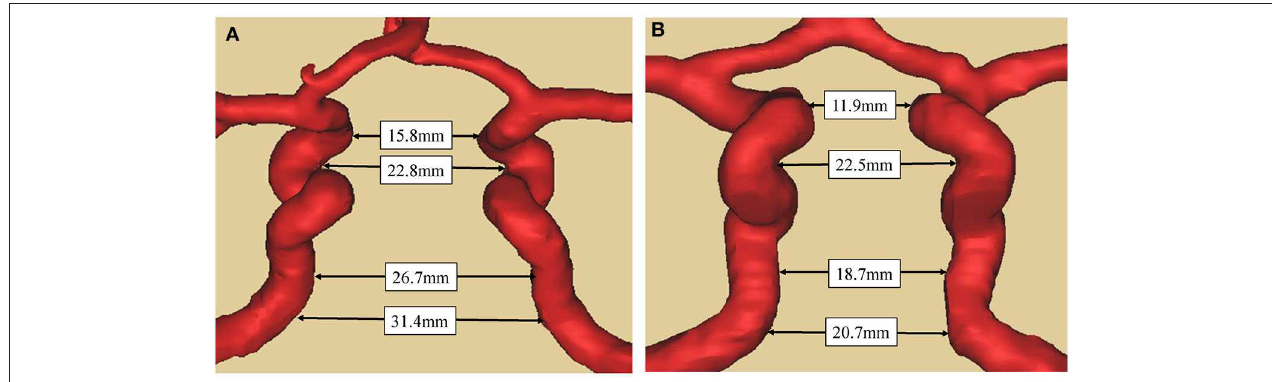
FIGURE 2 | Comparison of bilateral ICAs distance between acromegaly and non-functional pituitary adenoma patient (A) . Case 1, a 59-year-old man with acromegaly. The tumor diameter is 1.8cm with knosp gradeII. The distance between the bilateral ICAs at a-d level (as in Figure 1 ) were respectively 15.8, 22.8, 26.7, and 31.4mm. (B) . Case 2, a 61-year-old male with no-functional pituitary adenoma. The tumor diameter is 2.0cm with knosp gradeII. The distance between the bilateral ICAs at a-d level (as in Figure 1 ) were respectively 11.9, 22.5, 18.7, and 20.7mm. The two patients have the same gender and similar age, and similar diameter of pituitary adenoma and same knosp